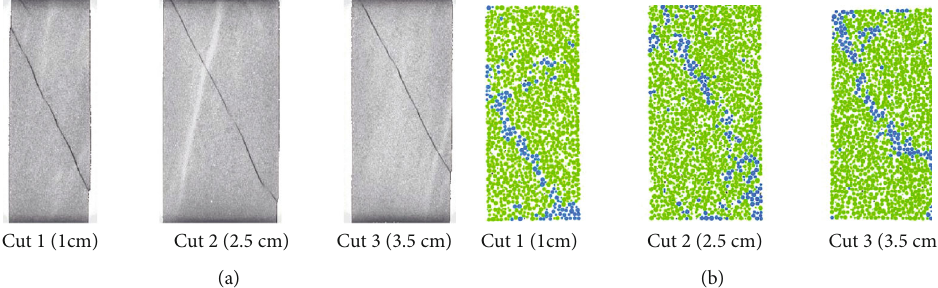
Figure 10: Comparison of internal fractures in red sandstone under 15MPa: (a) CT scan; (b) simulation.